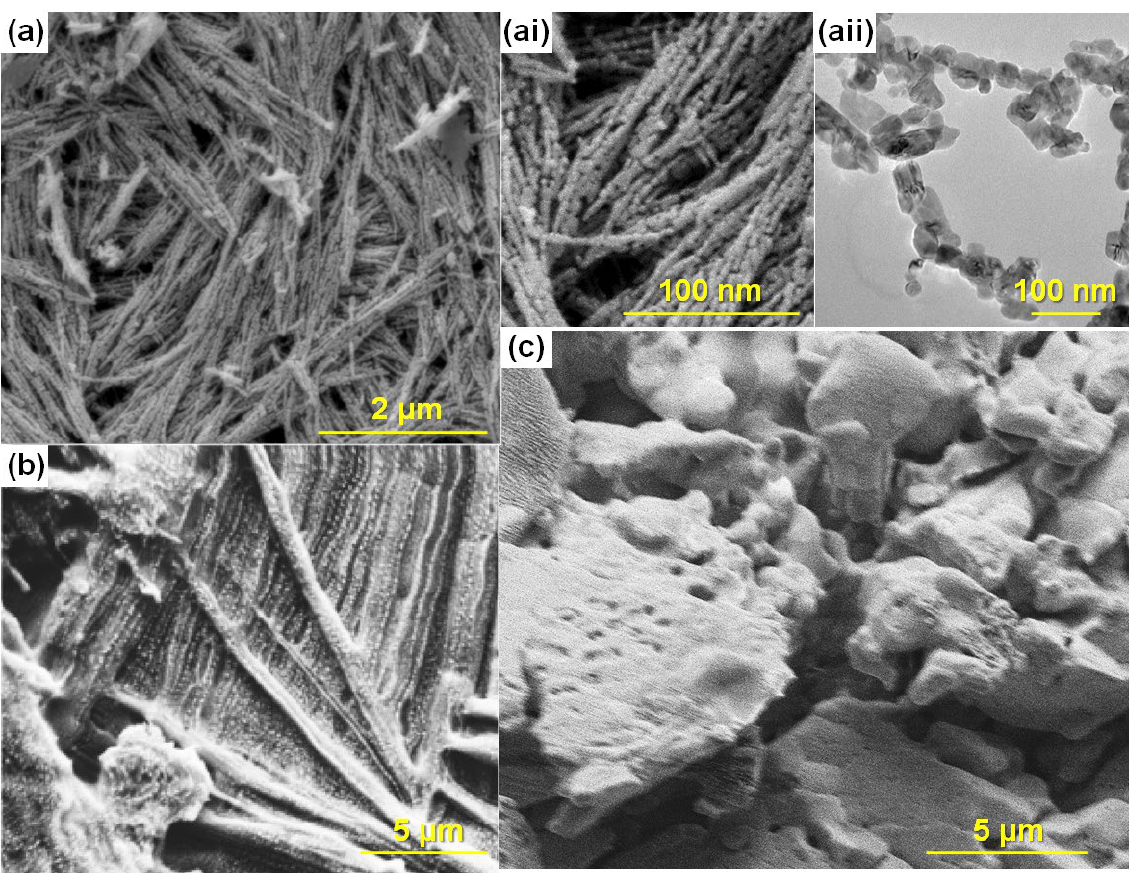
Figure 4. FESEM image of CuO-350 at ( a ) low magnification image, (i) high magnification image, (ii) HRTEM image of CuO-350; FESEM image for the PCGE sample of ( b ) TPAI-4 and ( c ) TCuO-350.